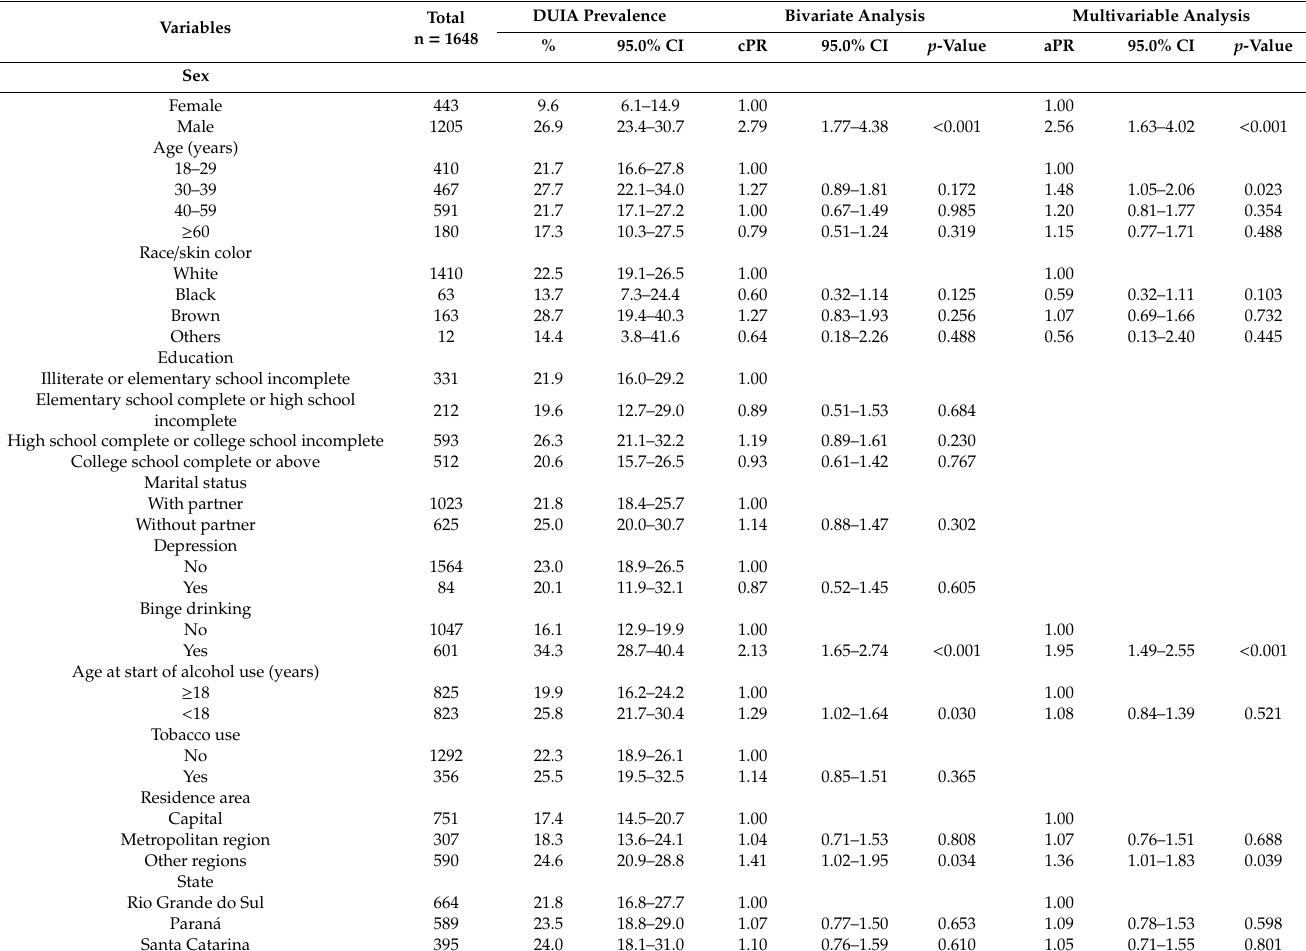
Table 3. Prevalence and Factors Associated with Driving Under the Influence of Alcohol in the South Macroregion, Brazil. National Health Survey, 2013. DUIA Prevalence Bivariate Variables Total n = 1648